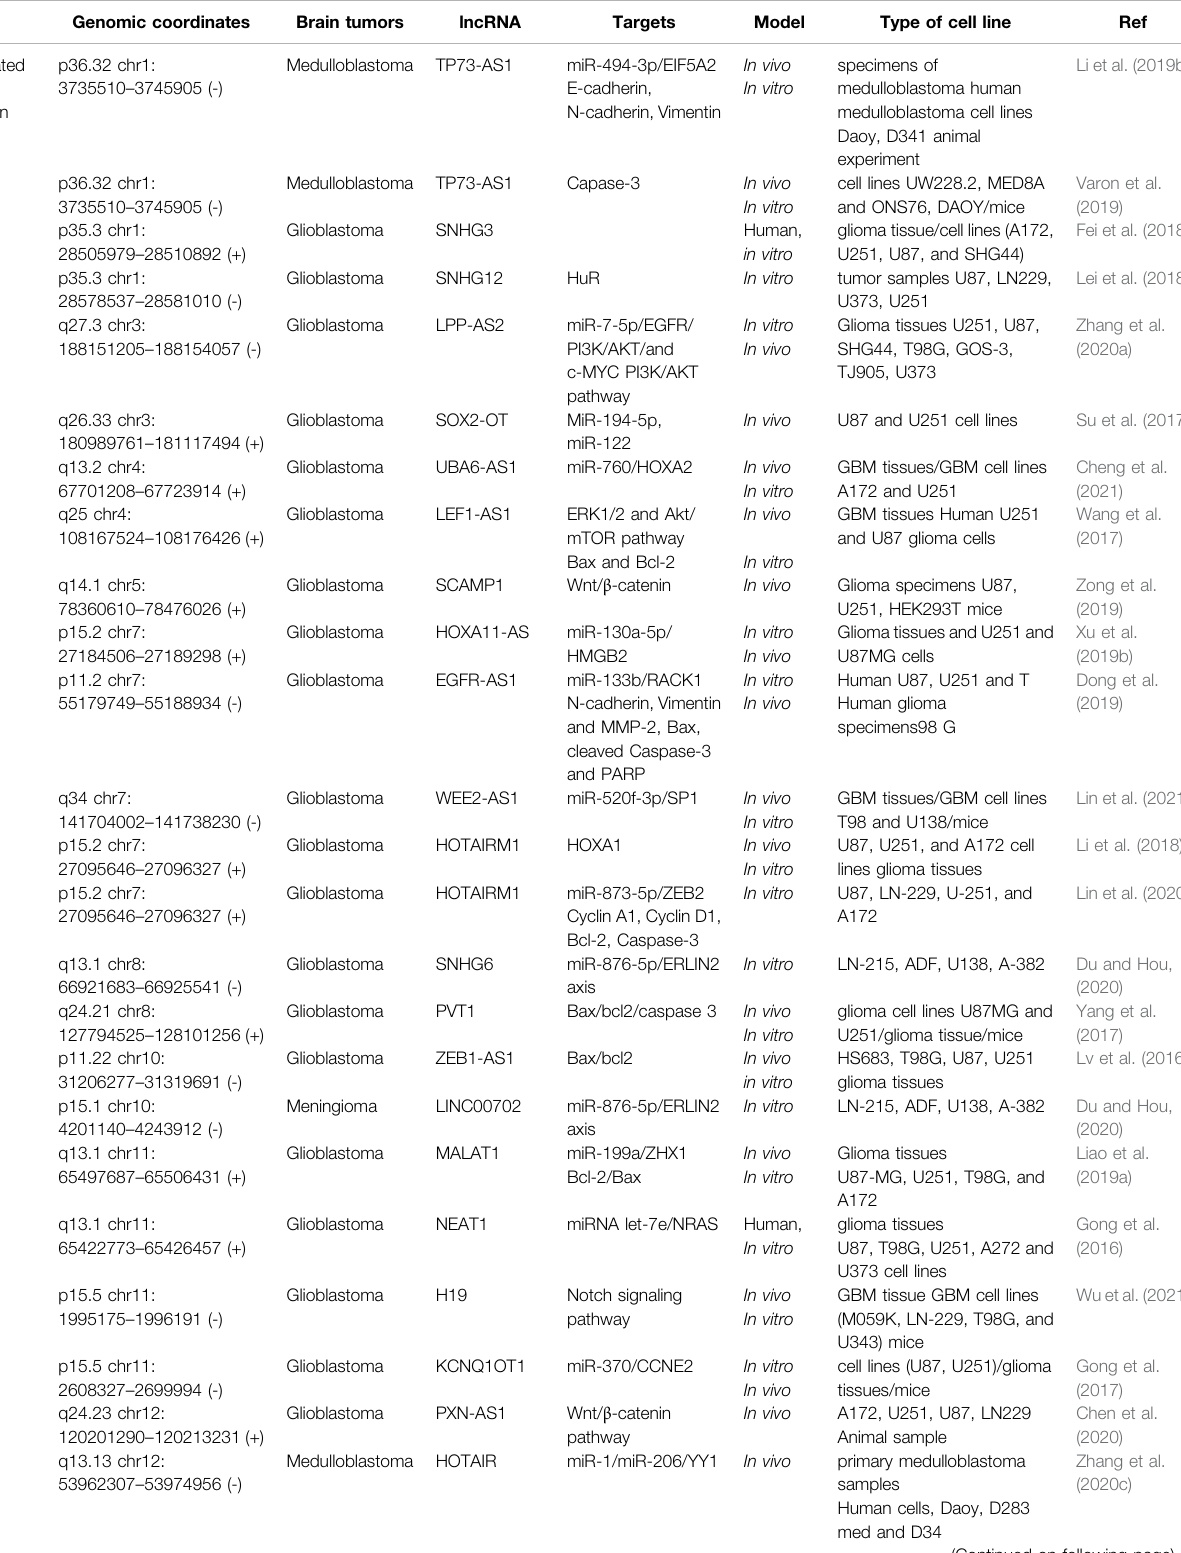
TABLE 2 | Apoptosis-related lncRNAs in brain